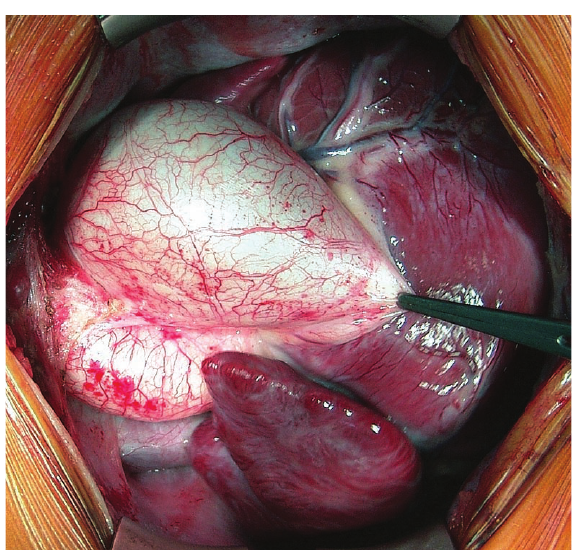
Fig. 2 – Aspecto da artéria pulmonar aneurismática tracionada.